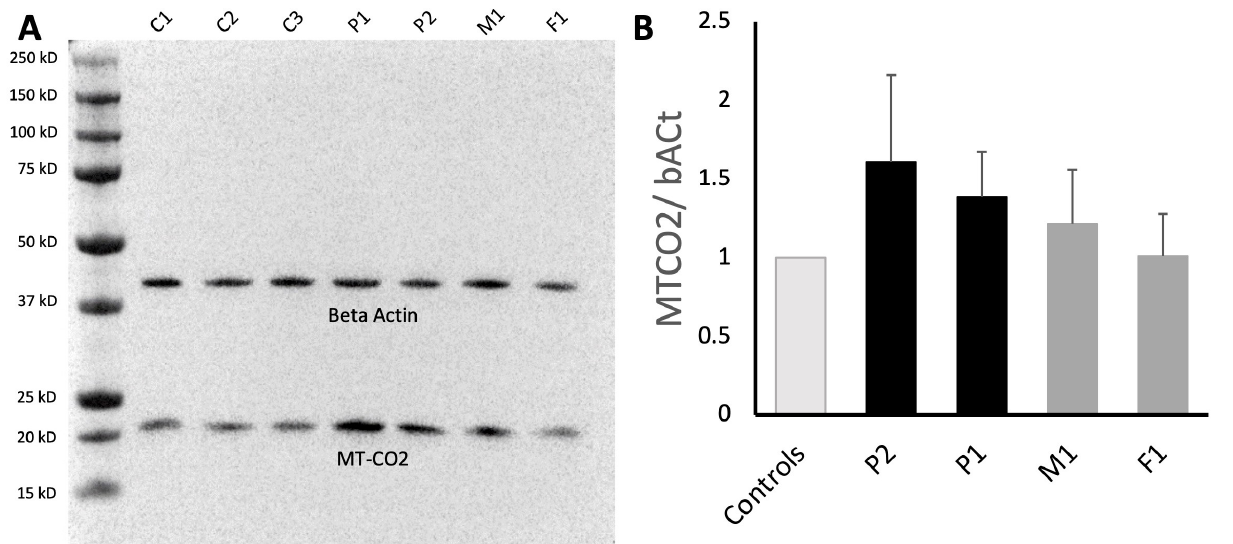
Figure 4. Analysis of the mitochondrially encoded Cytochrome C Oxidase II protein. ( A ) Representative Western blot for three controls (C1–C3), two biallelic patients (P1, P2), and two heterozygous unaffected relatives (M1, F1) showing protein levels of MT-CO2, which is increased in the patients and in M1 when compared to the controls. Beta-actin was stained as a control for equal loading. ( B ) Quantification of the signals from three Western blots was performed by analyzing the intensity and volume of the bands using Image Lab 6.1 (Bio-Rad). Ratio of MT-CO2 and β-actin was calculated first, followed by the mean value of all controls, which was standardized as 1. Mean values of patients (P1 and P2) and relatives (M1 and F1) are given as ratio to controls. Error bars: standard deviation. Light gray: wild type; dark gray: heterozygous carriers (parents); black: biallelic carriers (patients).